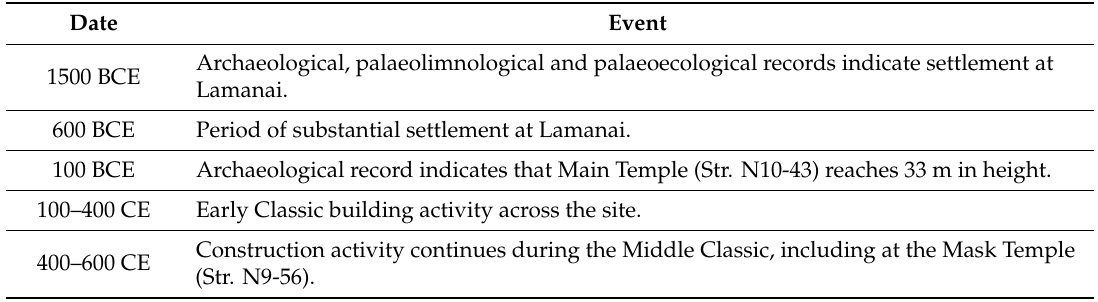
Table 1. Key events at Lamanai, Belize, 1500 BCE–1981 CE. Adapted from